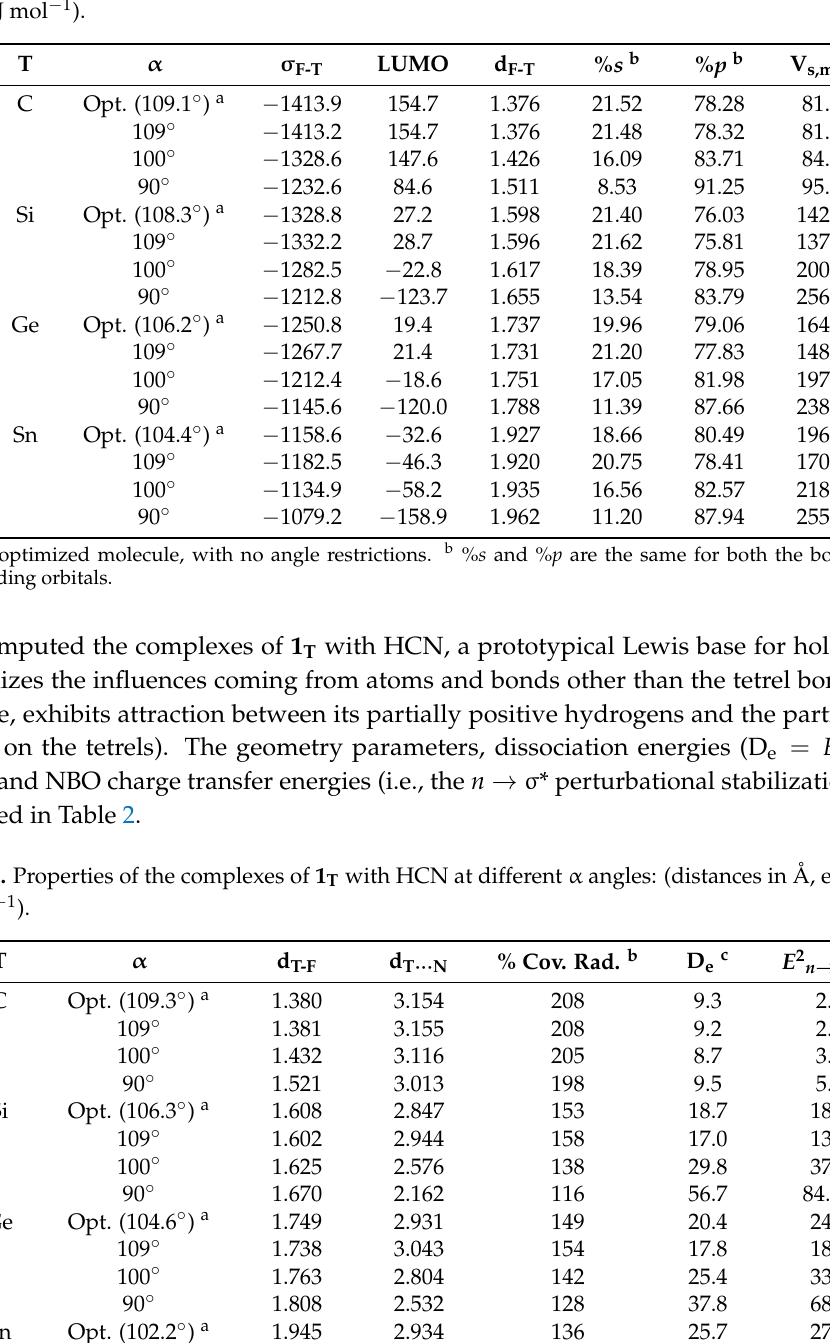
Table 1. Properties of 1 T with different σ angles: σ F-T and LUMO energies (kJ mol − 1 ), F-T bond length (Å), % s and % p on T in the NBO F-T σ bond, and the maximal positive electrostatic potential at the σ hole (kJ mol − 1 ).